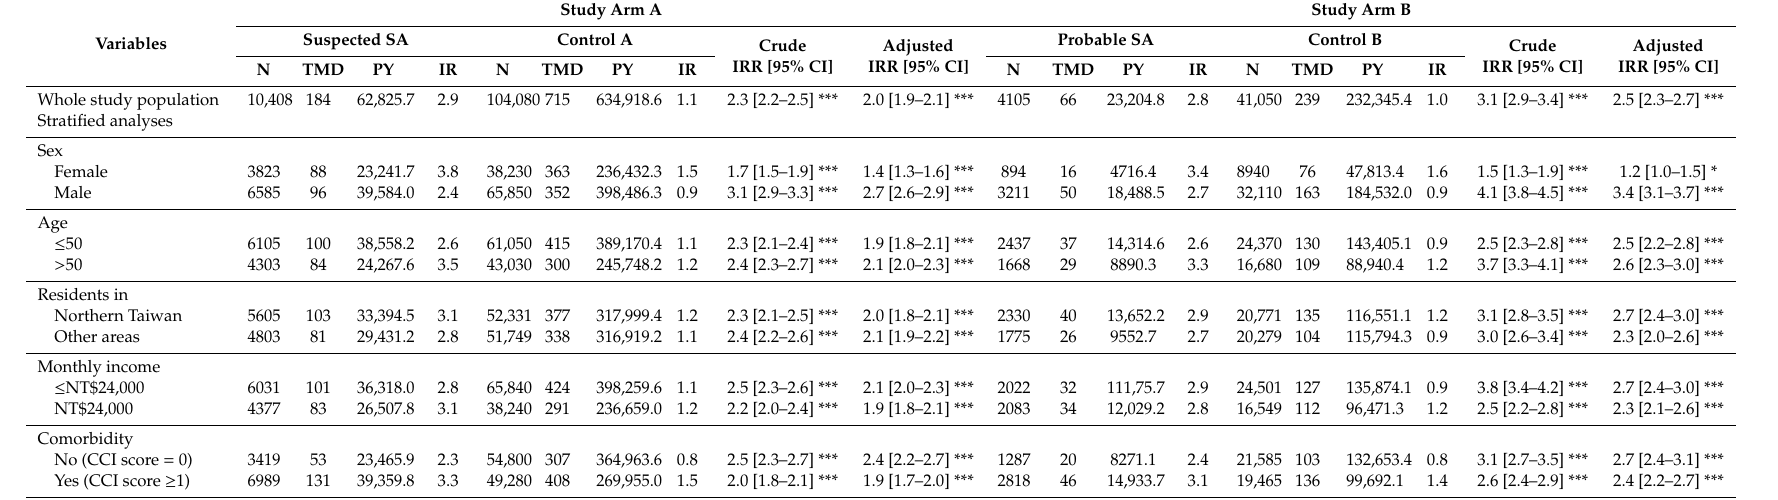
Table 2. Incidence rate of temporomandibular disorder (TMD) after the index date in each